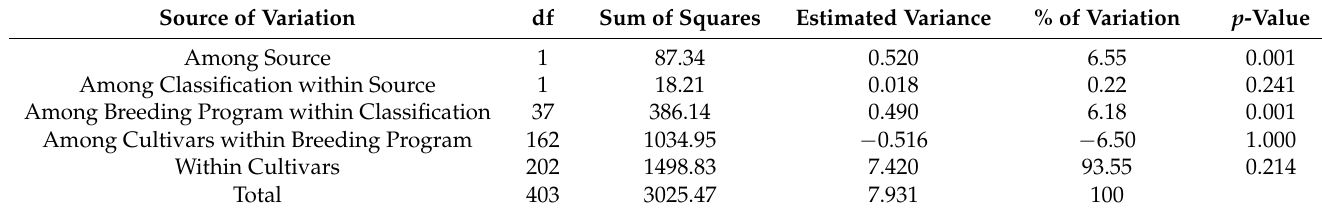
Table 4. Analysis of Molecular Variance (AMOVA) calculated using three population levels for 202 apricot accessions. Source of Variation df Sum of Squares Estimated Variance p -Value Among Source 1 Among Classification within Source